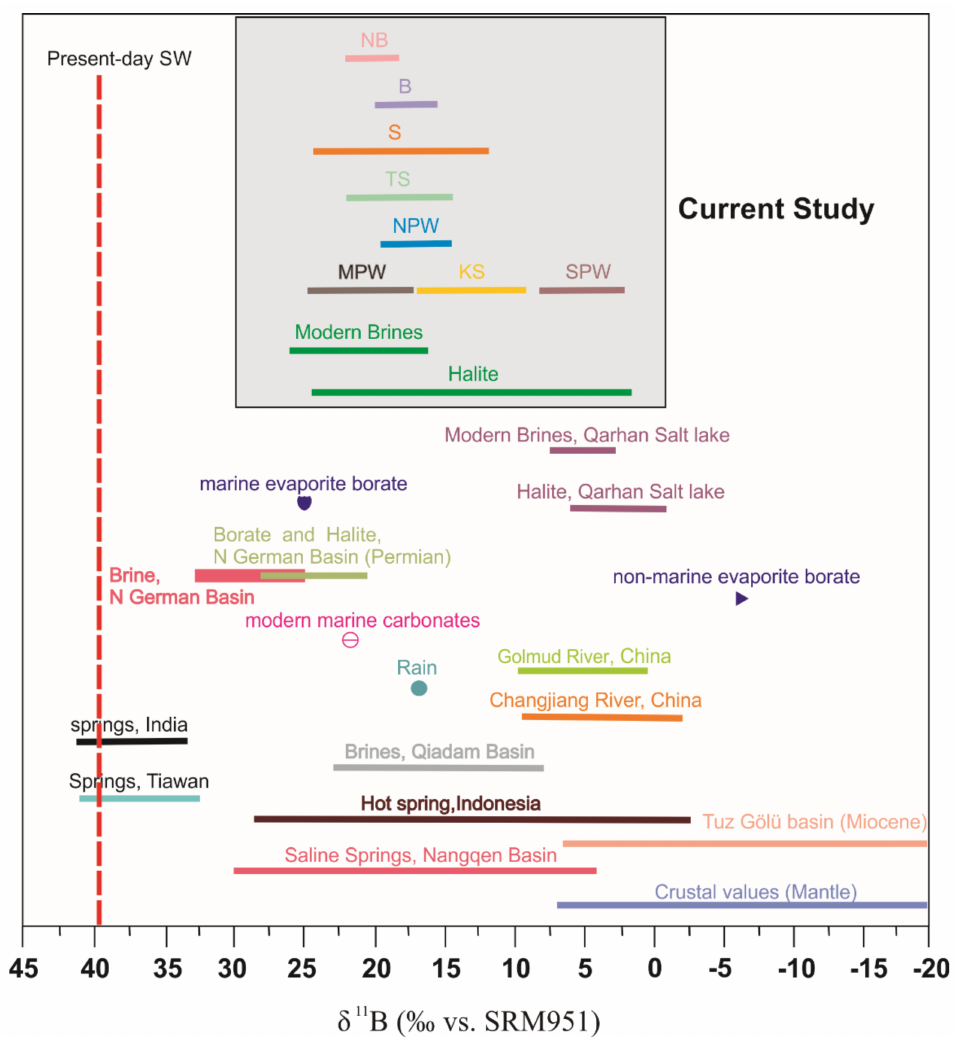
Figure 6. Comparison of the δ 11 B values of Halite and Brines from the Salt Range formation with the δ 11 B ranges of different materials. Data sources: crustal values from Chaussidon and Albarede (1992) [58]; Tuz Gölü Basin from Ercan at al. (2019) [65]; saline spring, China, hot springs, Indonesia, springs of Taiwan and India are from Han et al. (2018) [38]; Brines in Qiadam Basin, China from Xiao et al. (1999, 2000) [24,59]; River values from (Chetelat et al., 2009; Vengosh et al., 1995) [61,62], Rain water from Xiao et al. (1992) [65]; modern marine carbonate from Hemmin and Hanson (1991) [43]; Borate and halite, N German Basin from Kloppmann (2001) [66]; marine and non-marine evaporate borate from Swihart and Moore (1986) [55]; modern brine and halite, Qarhan salt lake from Fan et al. (2015) [5], whereas, brine and halite, Salt Range data is from the current